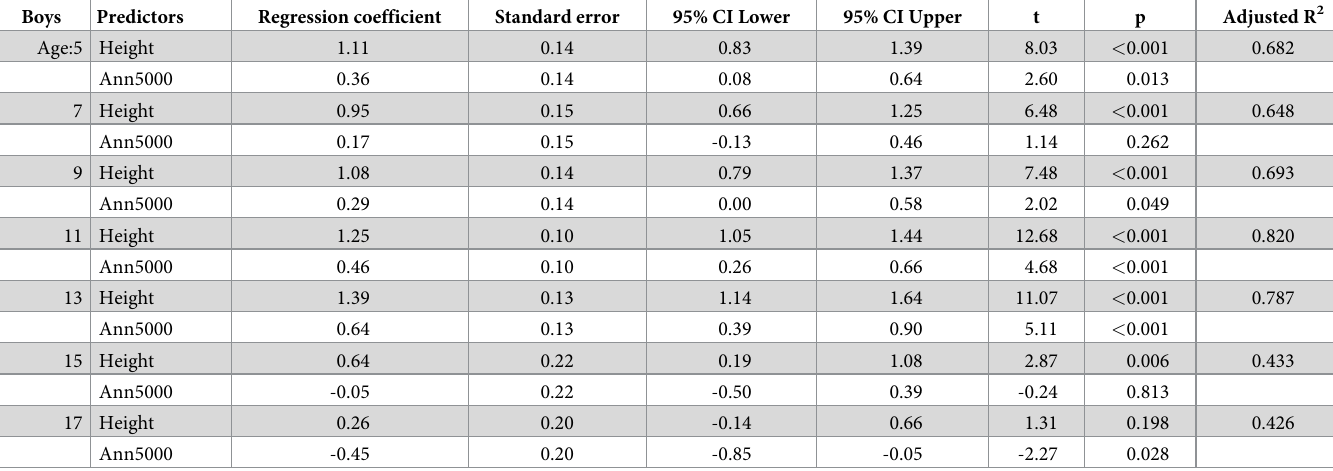
Table 6. Regression coefficients (standard errors) of predictors of weight (boys).